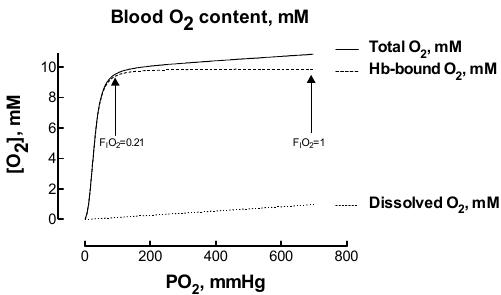
Figure 1. Oxygen content in arterial blood at varying PO 2 . The O 2 content is calculated assuming a blood hemoglobin (Hb) concentration of 16 g/dL, the O 2 solubility coefficient of 0.0014 millimoles/L/mmHg [22] and the Hb-O 2 equilibrium curve in healthy humans [23].